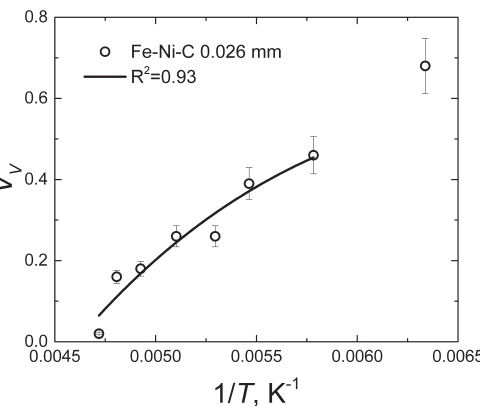
Fig. 7 – Volume fraction of martensite plates per unit of volume against transformation temperature. Fe-32wt%Ni-0.004wt%C alloy 5 with a mean intercept length of austenite grains equal to 0.121 mm. Solid line corresponds to the model developed here: equation 9. Error bars corresponding to an estimated relative error of ±10% were added to the plot. Outlier was excluded from the fitting.